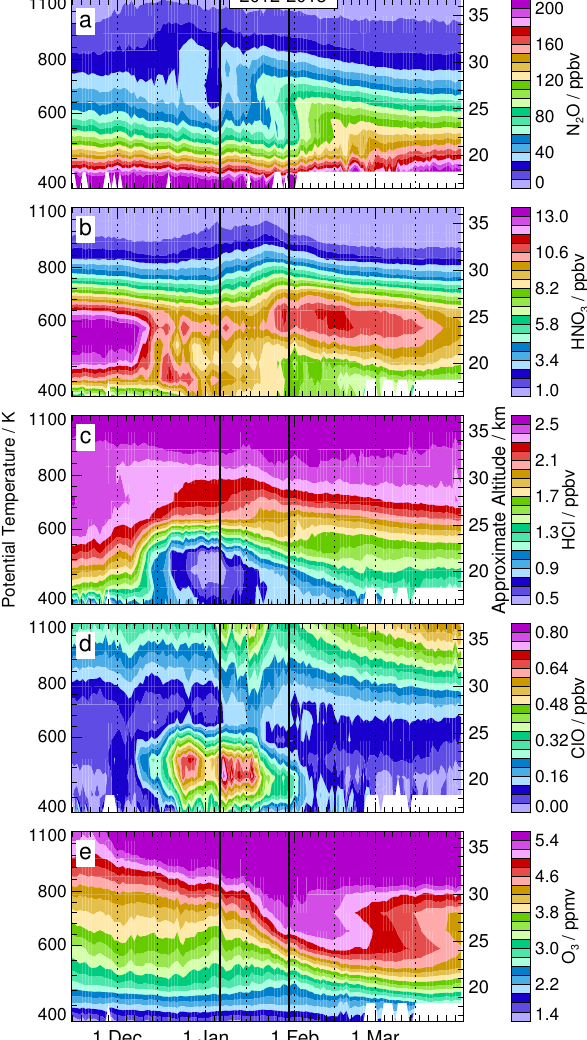
Figure 9. Potential temperature/time series of vortex-averaged (within the 1 . 4 × 10 − 4 s − 1 sPV contour) (a) N 2 O (color bar range 0 to 210ppbv), (b) HNO 3 (color bar range 1.0 to 13.6ppbv), (c) HCl (color bar range 0.5 to 2.6ppbv), (d) ClO (color bar range 0 to 0.84ppbv), and (e) O 3 (color bar range 1.4 to 5.6ppmv) derived from MLS data. The thin solid black vertical lines indicate the on- set day of the SSW (6 January, ∼ 2 days before the vortex split) and the day when the offspring vortices reunited (30 January).